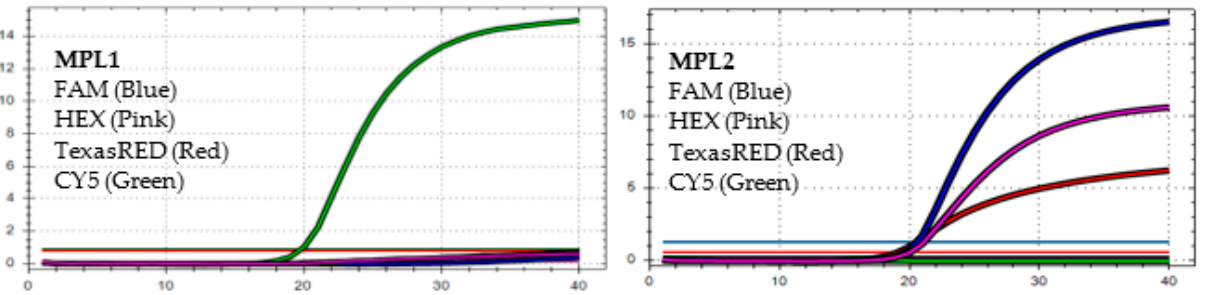
Figure 1. In MPL1 , the target failures are detected in 3 channels, FAM, HEX, and TexasRED. In MPL2 ,